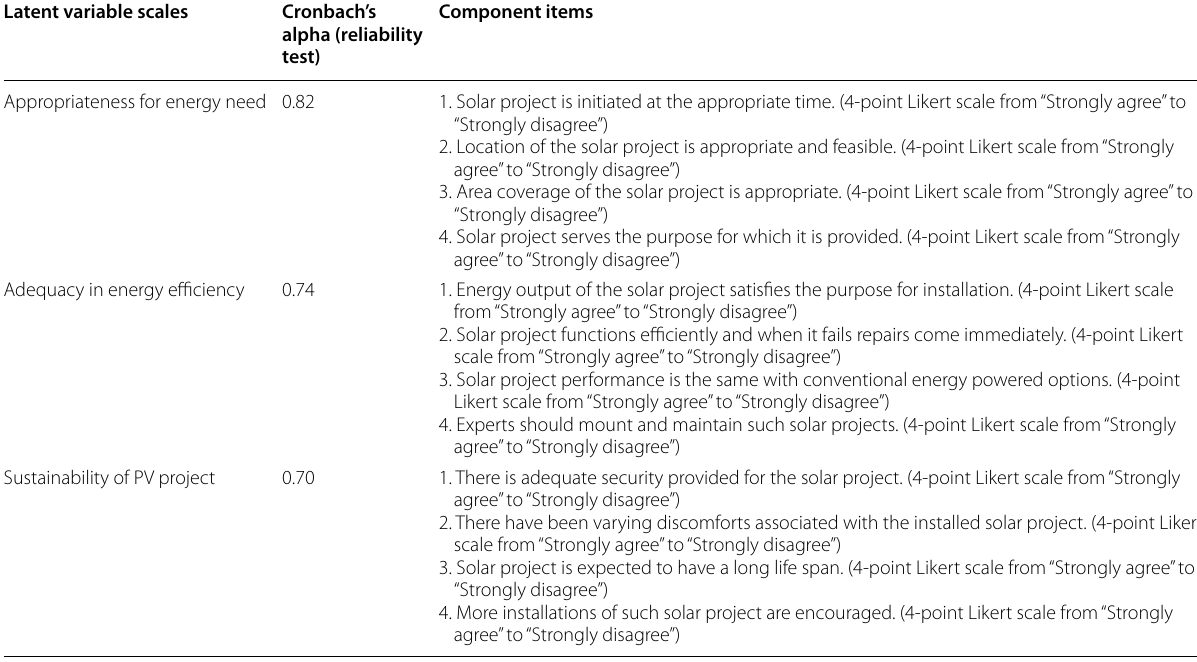
Table 2 Latent variable scales in the PV projects Technical audit with their respective reliability and component items Latent variable scales Cronbach’s Component items alpha (reliability test)